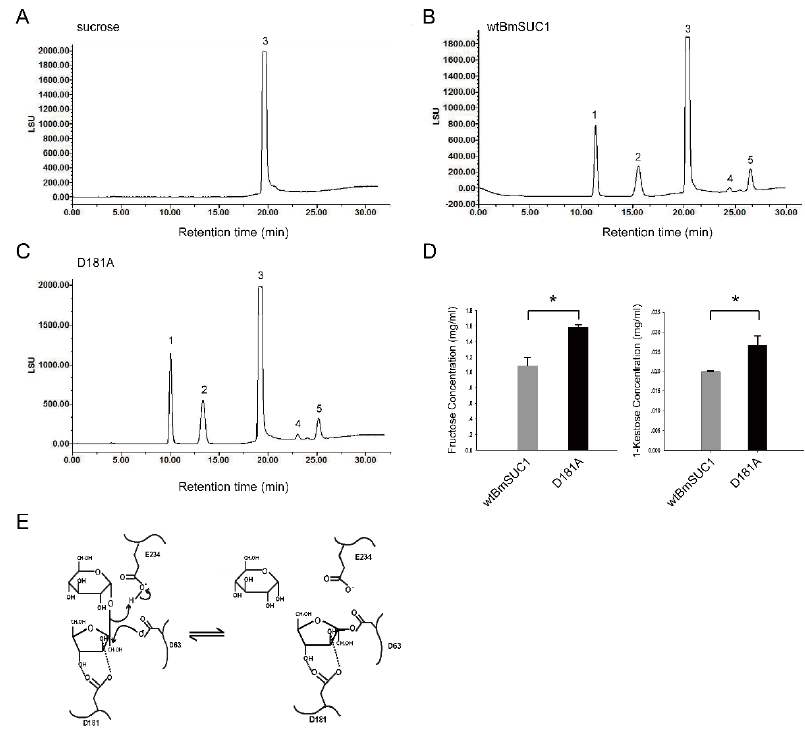
Figure 4. Determination of transfructosylation activity using sucrose as substrate and quantitative analysis on wtBmSUC1 and D181A by HPLC-ELSD ( A – D ). ( A ) Sucrose control without addition of enzyme in the reaction mixture; Peaks in ( B , C ) indicate fructose (1), glucose (2), sucrose (3), 1-kestose (4) and 6-kestose (5), respectively; ( D ) Comparison of fructose and 1-kestose catalyzed by wtBmSUC1 and D181A. * p < 0.05; ( E ) possible reaction mechanism of BmSUC1 acting as β -FFase. D63, D181 and E234 represent the nucleophile, transition-state stabilizer, and acid/base catalyst, respectively [25].